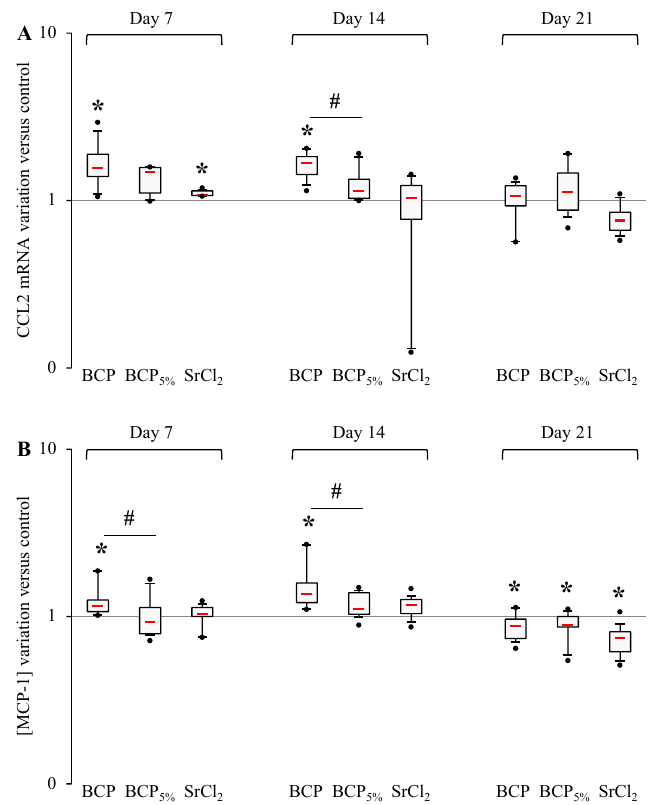
Figure 2. Strontium effect on MCP-1 production by human primary bone cells. ( A ) CCL2 and mRNA expression was evaluated by RT-PCR analysis performed (as described in the Materials and Methods section) after 7, 14 and 21 days of stimulation by BCP, BCP 5% , and SrCl 2 . Experiments were performed on 5 independent donors in duplicate. Data are shown as specific variation of target genes mRNA using the 2 −ΔΔ Ct method (HPRT1 was used as internal control); ( B ) MCP-1 concentration was measured in cell supernatants after 7, 14, and 21 days of stimulation by BCP, BCP 5% , and SrCl 2 . * means p < 0.05 when compared with control and # p < 0.05 when compared with BCP. Red bars represent median values. Black points represent maximum and minimum values. Black bars represent first and ninth deciles and the limits of white rectangles represents first and third quartiles.